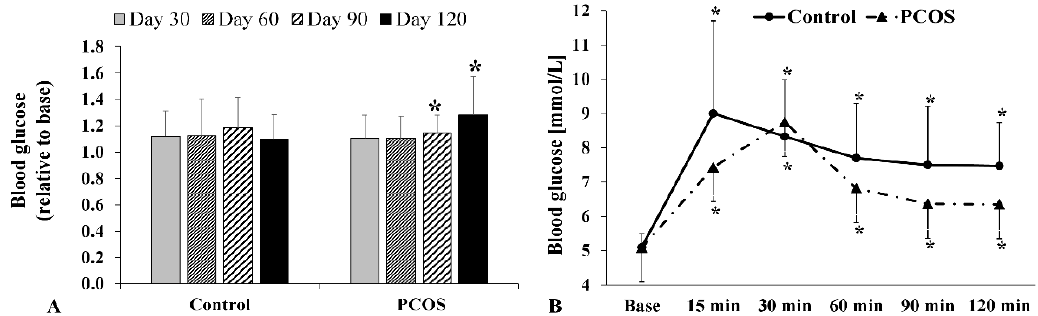
Figure 2. Changes in blood glucose concentration ( A ) and the results of oral glucose tolerance test (OGTT) ( B ) of the Control and polycystic ovary syndrome (PCOS) groups. Means ± S.D.; * p < 0.05 vs. Base.